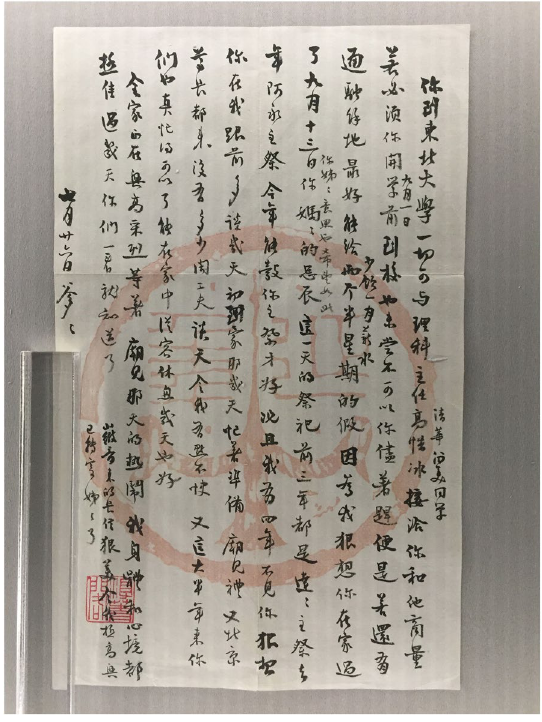
Fig. 3 Letter from Liang Qichao to Liang Sicheng, informing him of the founding of the Department of Architecture and Engineering at Northeastern University and accepting the chairmanship of the department on his behalf (Source: the